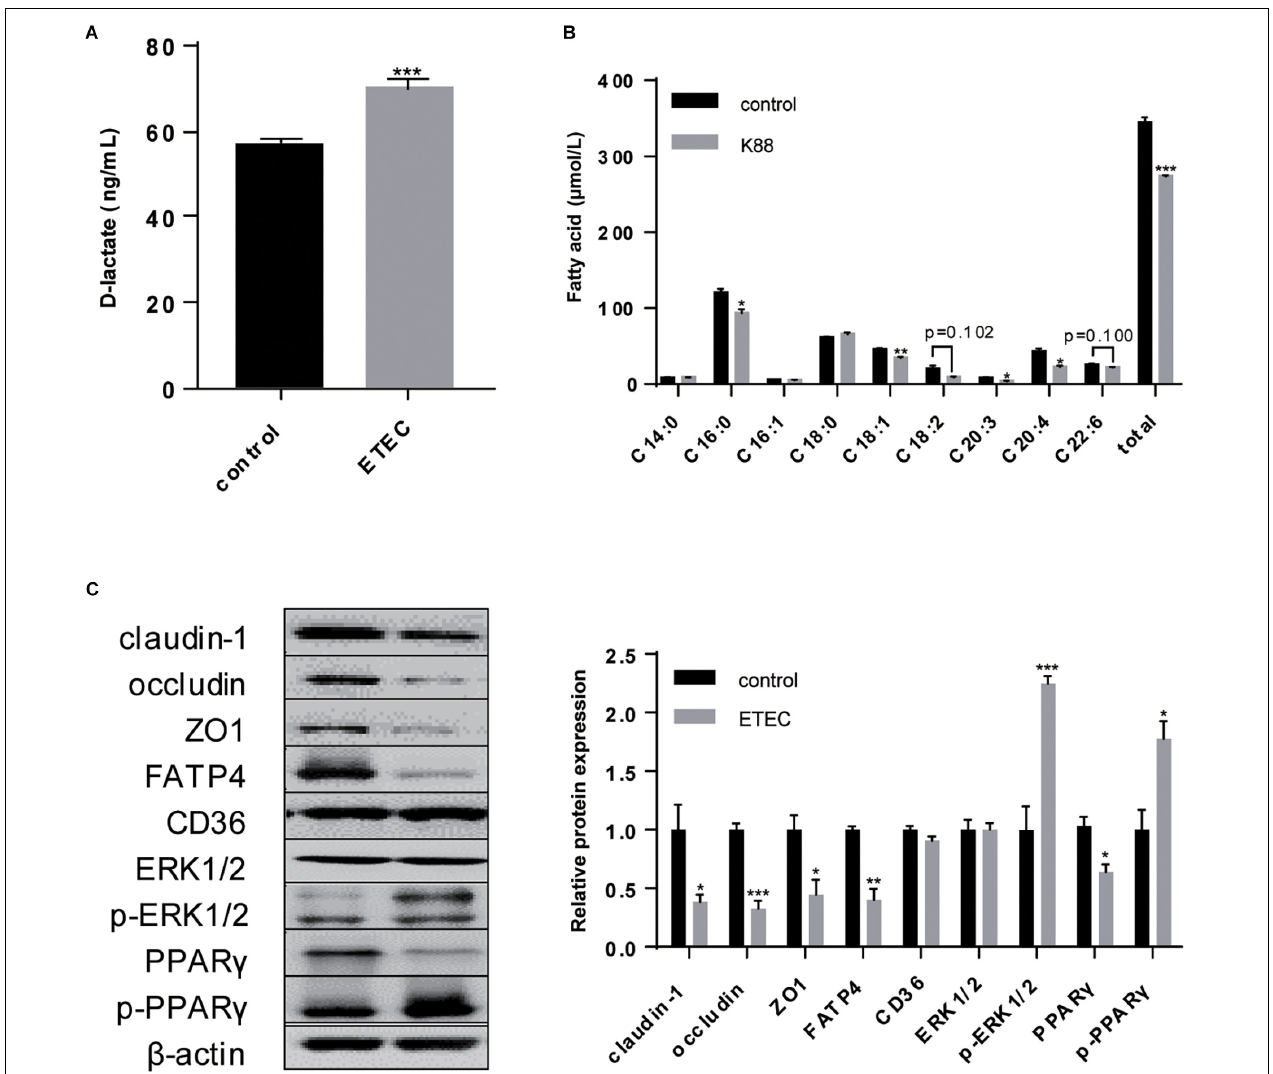
FIGURE 1 | Effects of ETEC gavage on weaning piglets. (A) D-lactate content in piglet serum. (B) Gas chromatographic analysis of FA in piglet serum 3-h after gavage with olive oil. (C) Western-blot analysis of TJs claudin-1, occludin, ZO1; FA uptake associated proteins FATP4 and CD36; signaling pathway proteins ERK1/2, p-ERK1/2, PPAR γ , p-PPAR γ . Data are presented as mean ± standard error. ∗ P < 0.05, ∗∗ P < 0.01, and ∗∗∗ P <